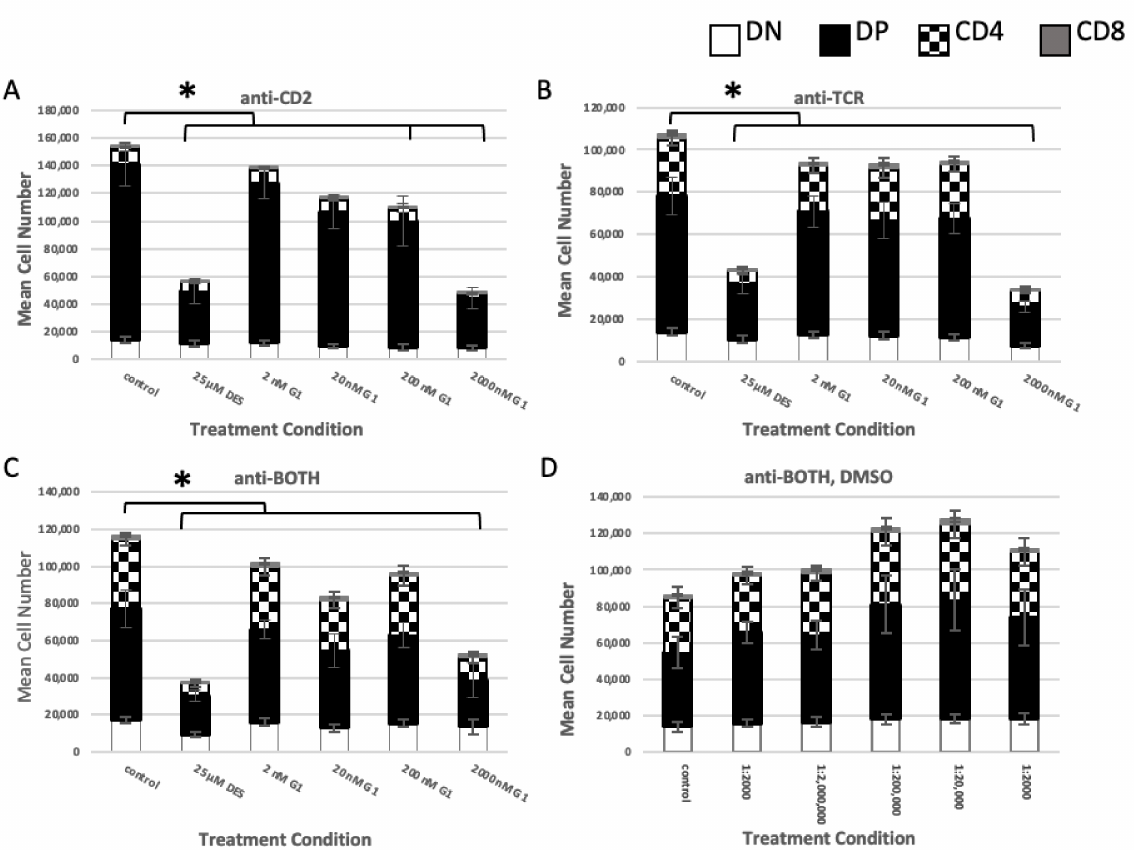
Figure 3. G protein-coupled estrogen receptor (GPER) agonist G1 induces cell death like DES in treated embryonic thymocytes. Embryonic thymocytes were treated with G1 and 50 µ M DES during incubation in the differentiation culture. Treated thymocytes were cultured 18–24 h in the presence of ( A ) anti-CD2, ( B ) anti-TCR, ( C ) anti-BOTH, and ( D ) anti-BOTH, DMSO. N = 8, * Tukey HSD post-hoc p ≤